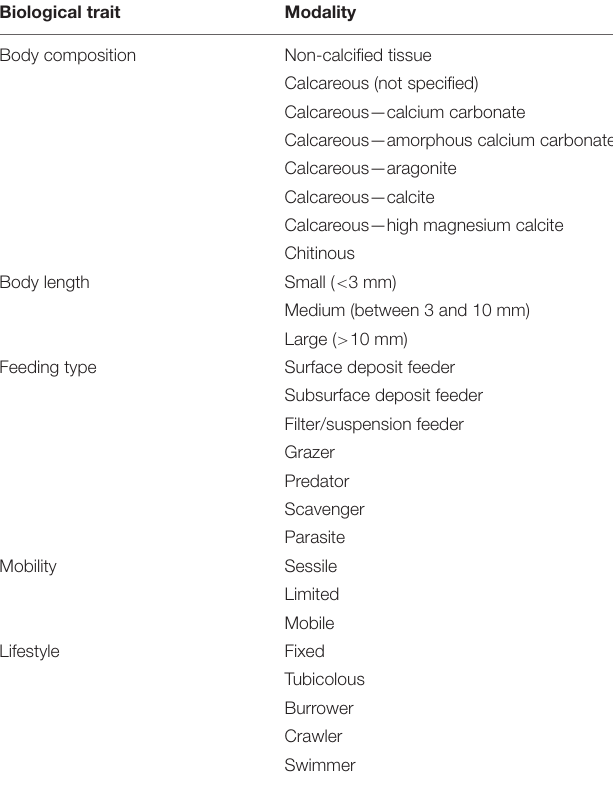
TABLE 2 | Summary of the functional traits and